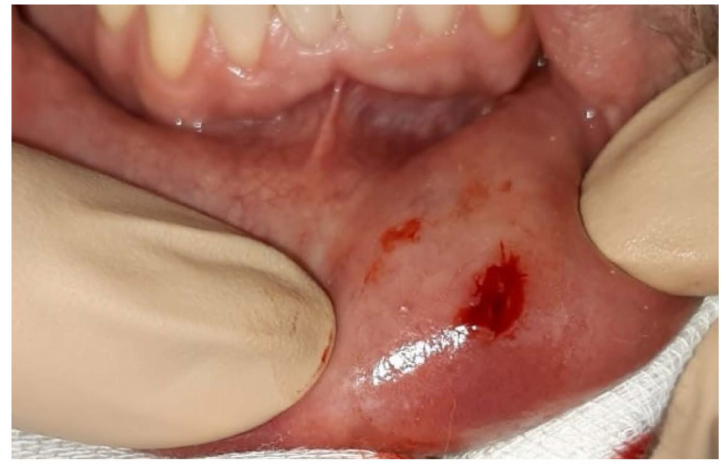
Figure 1. Wound on lower lip after surgical extraction of the parasite.